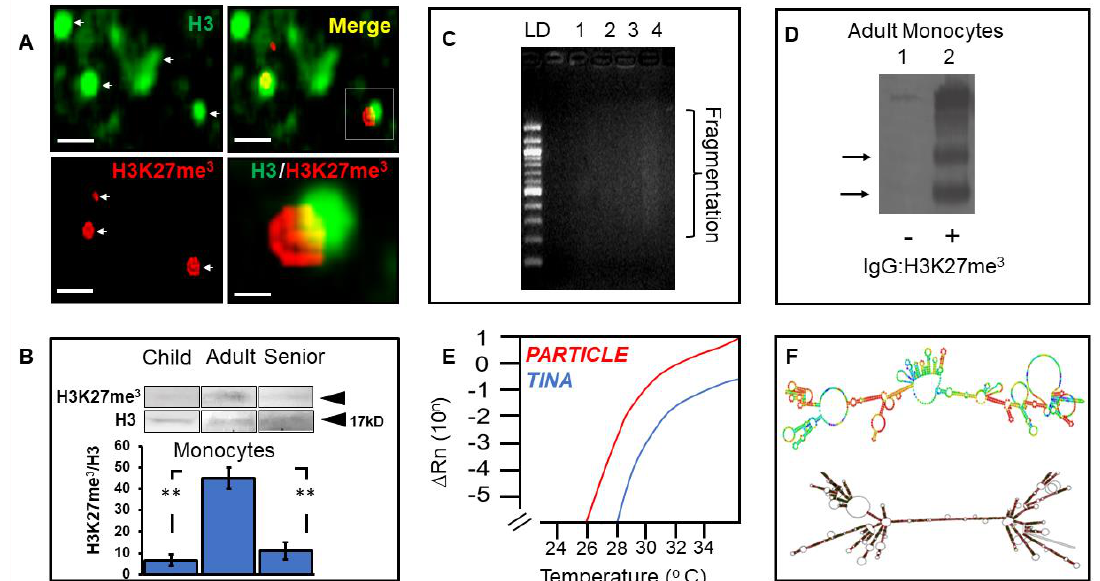
Figure 4. Monocytes from adults reveal elevated histone 3 K27 trimethylation and association with long non − coding RNAs PARTICLE and TINA . Epifluorescence micrographs of histone 3 (green) and lysine 27 methylation (red) in monocytes from adults. Scale bars 10 µ m—upper and lower left panels; 2 µ m—lower right panel ( A ). Merged images (yellow). Representative Western blot of H3K27me3 levels in histone 3 (H3) in monocytes extracted from a child, an adult, and a senior (above) with histograms showing group comparisons (below) ( B ). Asterisks represent significance between groups ( n = 4; ** p ≤ 0.006). Gel electrophoresis of genomic DNA showing fractionation range after sonication. DNA 100 bp ladder (LD), fractionated genomic DNA after 5, 10, 15, and 30 s of sonication (Lanes 1–4 respectively) ( C ). Western blot after chromatin immunoprecipitation with/without anti − H3K27me3 (plus/minus). Arrows indicate the presence of histone 3 K27me3 in monocytes extracted from adults ( D ). Amplification curves of long non − coding RNAs PARTICLE and TINA following ChIP − RNA pulldown in monocytes from adults ( E ). Secondary structure of lncRNA TINA (left), comparative LOCARNA structural comparison with lncRNA PARTICLE (right)—dark bases indicative of stoichiometric similarity ( F